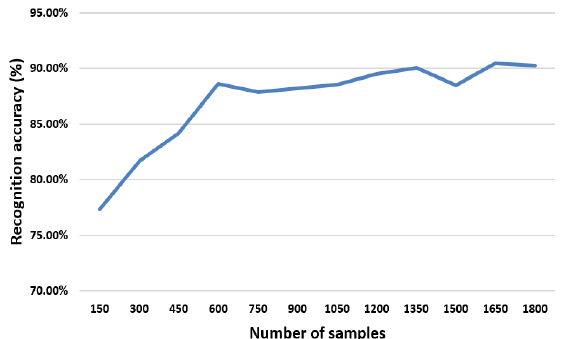
Figure 4. Diagram of recognition accuracy for different sample